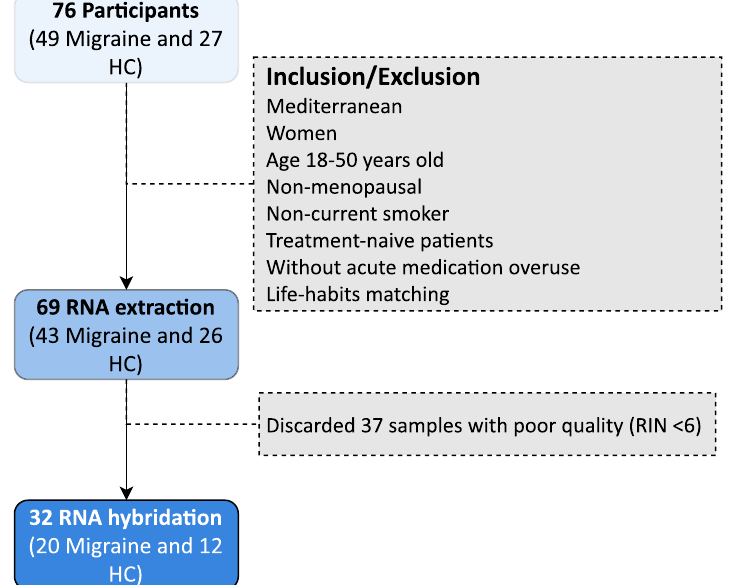
Fig. 1 Patients’ recruitment flowchart. We recruited participants from August 2016 to September 2017. HC: healthy controls; RIN: RNA integrity number; QA: quality